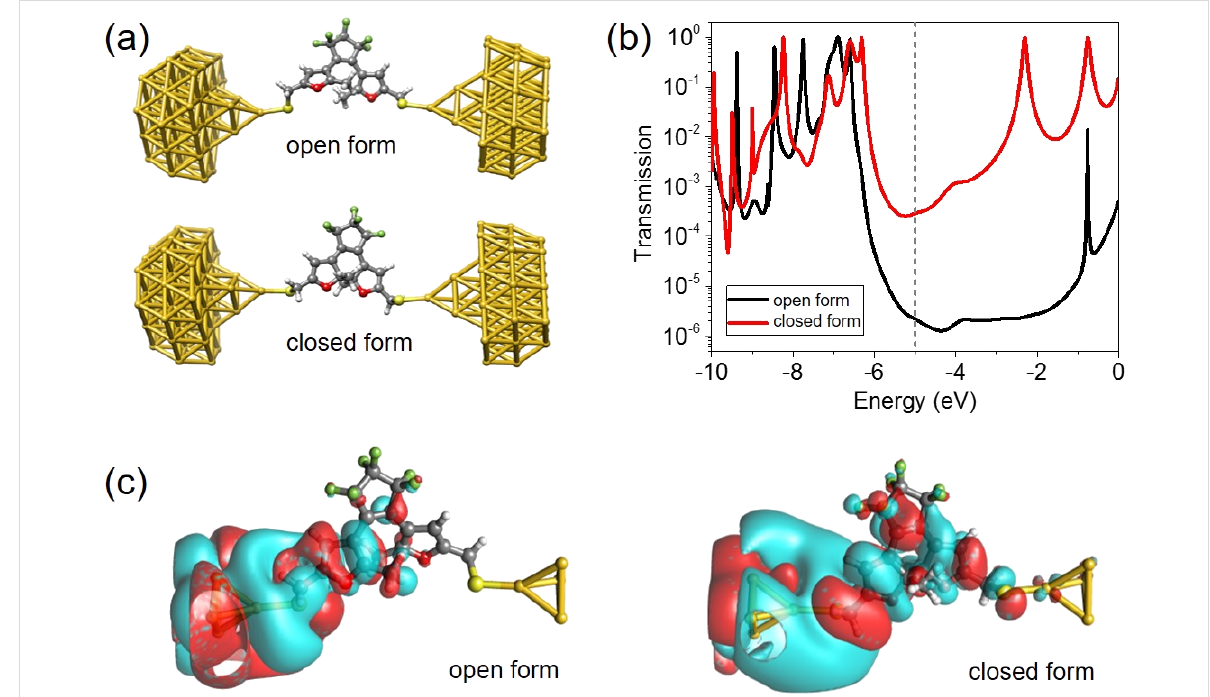
Figure 2: (a) The geometric structure used in the DFT calculations is displayed for the open and closed forms of Au-C5F-ThM-Au junctions. (b) The computed transmission curves for the open (black) and the closed form (red). (c) The wavefunction of the dominant transmission eigenchannel for electrons coming in from the left side for the open (left) and the closed form (right). Red and turquois indicate different signs of the